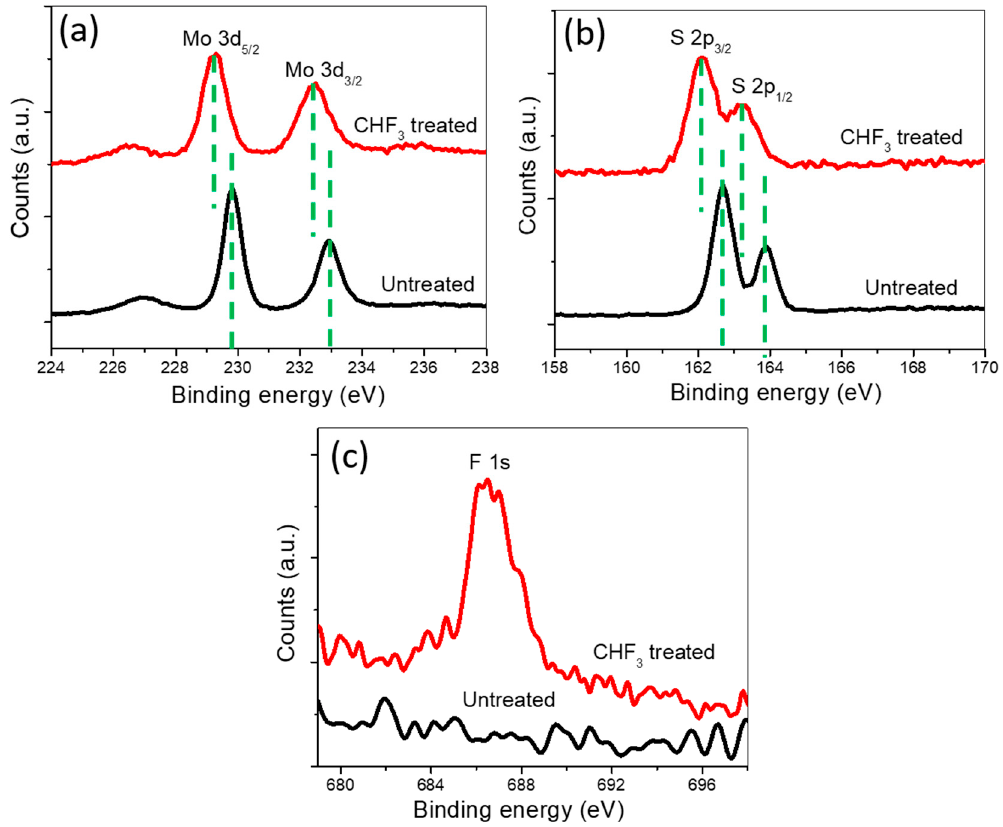
Figure 3. X-ray photoelectron spectroscopy (XPS) spectra for ( a ) Mo and ( b ) S signals before and after plasma treatment, showing a downshift of 0.57 eV in binding energy for all peaks. ( c ) XPS spectra for MoS 2 exhibit the presence of the F 1s peak in CHF 3 plasma-treated MoS 2 .